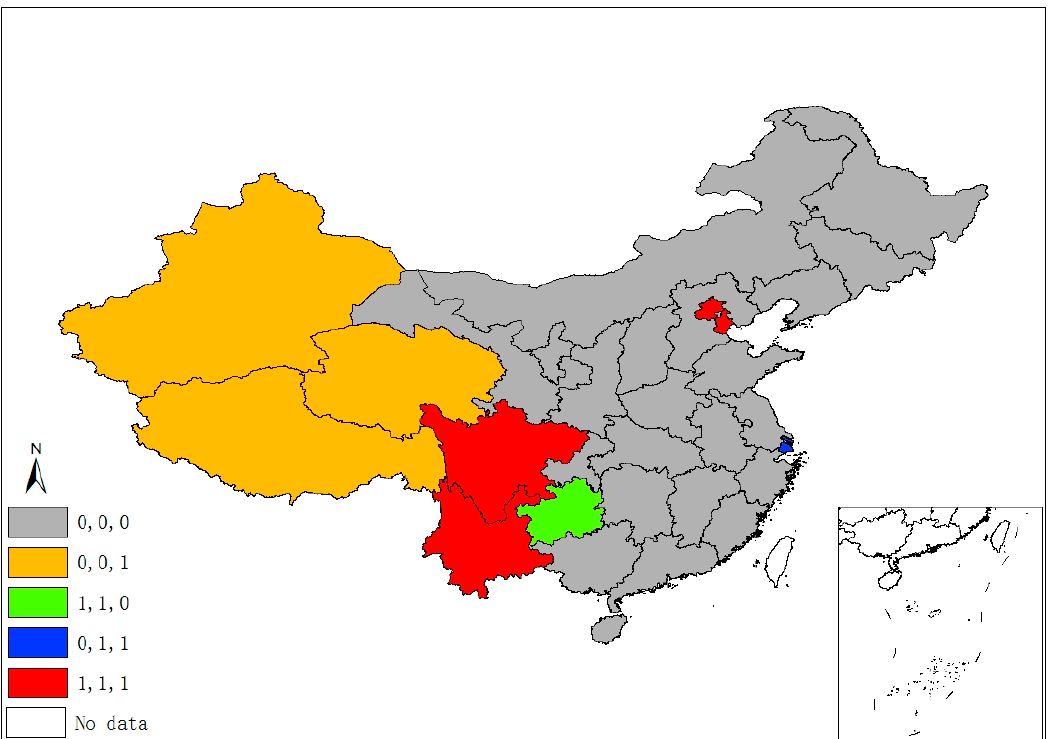
Figure 5. Spatiotemporal significant spots of urbanization level (urb) .